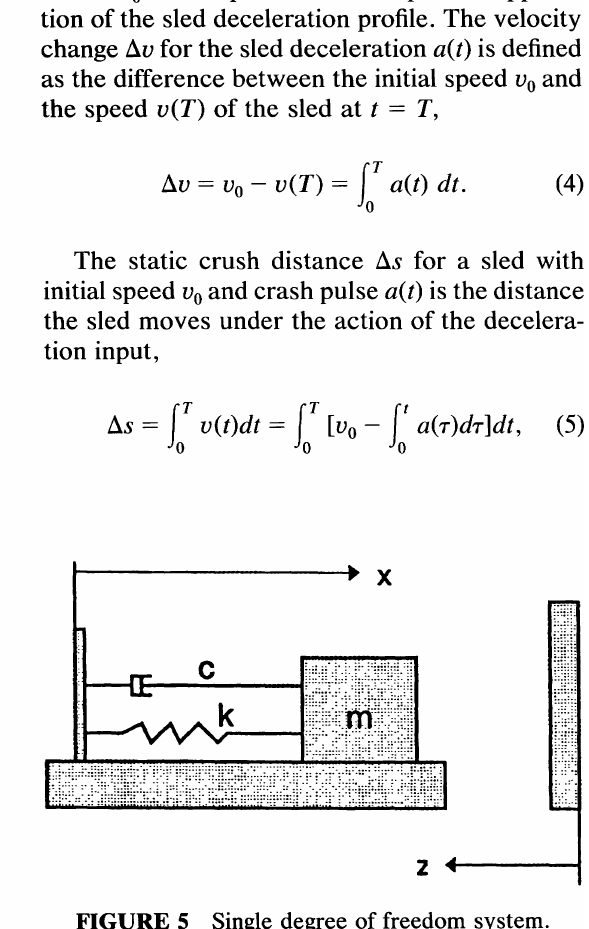
FIGURE 5 Single degree of freedom